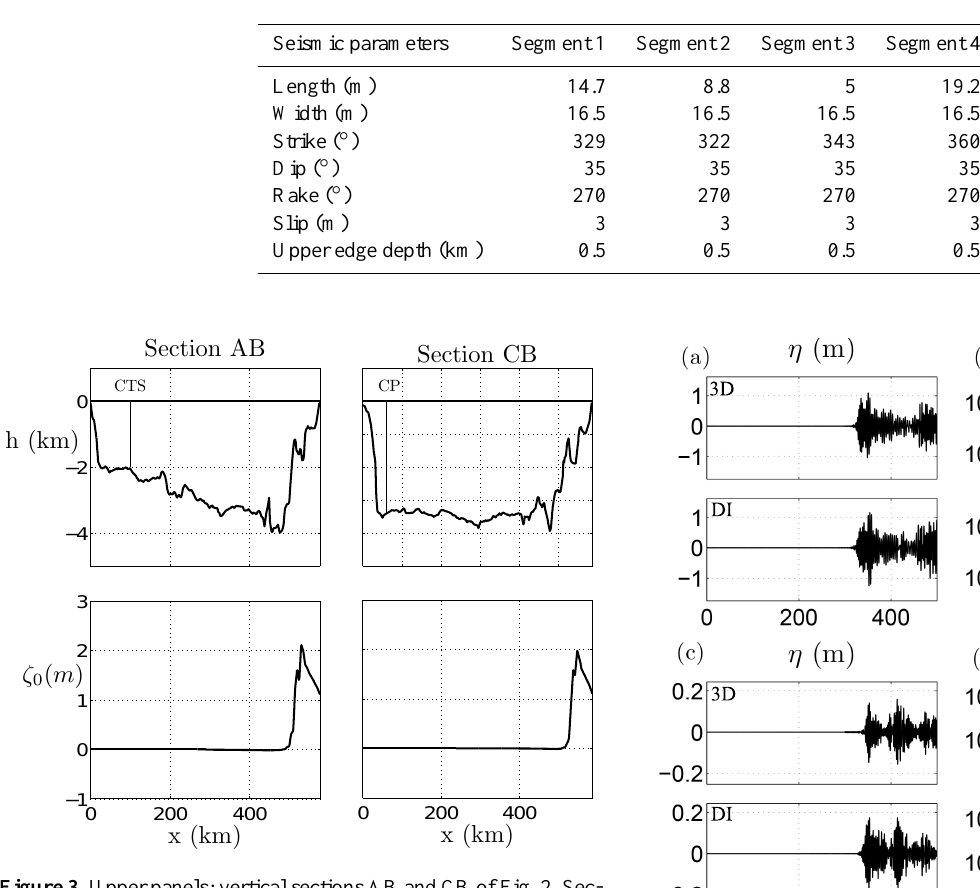
Figure 3. Upper panels: vertical sections AB and CB of Fig. 2. Sec- tion AB contains the location of the Catania submarine observa- tory, while section CB the Capo Passero Observatory. Lower pan- els: residual vertical sea bed displacement ζ 0 relative to the above vertical section. Figure 4. Free-surface time series (left column) and their relative